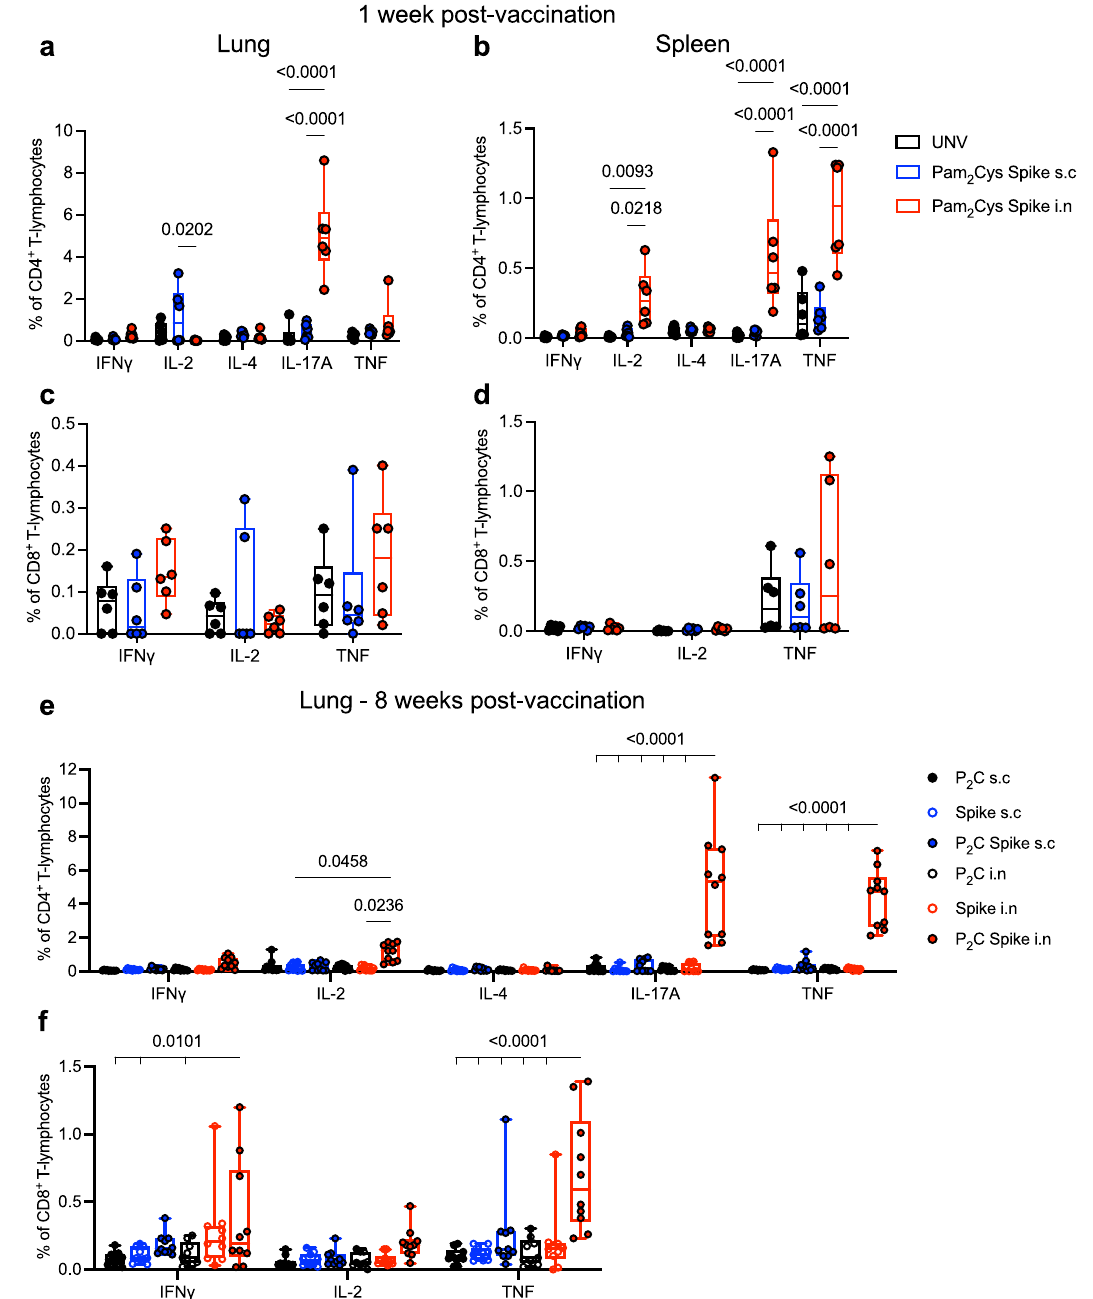
Fig.3|Mucosalvaccinationinducespotentlung-localizedandcirculatingIL-17- producing Spike-speci fi c CD4 + T-cells. C57BL/6 mice were immunized with Pam 2 Cys (P 2 C), Spike sub-cutaneously (s.c; blue) or intra-nasally (i.n; red) three times,2weeksapart.Controlmicewereunvaccinated(UNV;black a – d ),orreceived P 2 C adjuvant only (black, e , f ). The frequency of antigen-speci fi c cytokine-produ- cing ( a ) CD4 + T-cells in the lungs and b spleen, or c CD8 + T-cells in the lungs and d spleenatoneweekpost fi nalvaccination( n =6animals),and e CD4 + T-cellsinthe